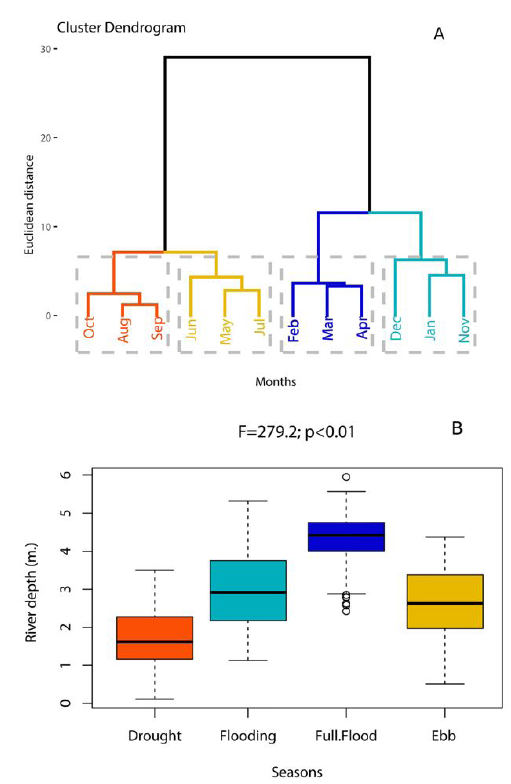
Figure 2. Hydrological period of the Northern Pantanal showing the differences between the months (A) and the seasons (B) considering a time series from 1971 to 2013. Note: same colors were used to differentiate hydrological periods.